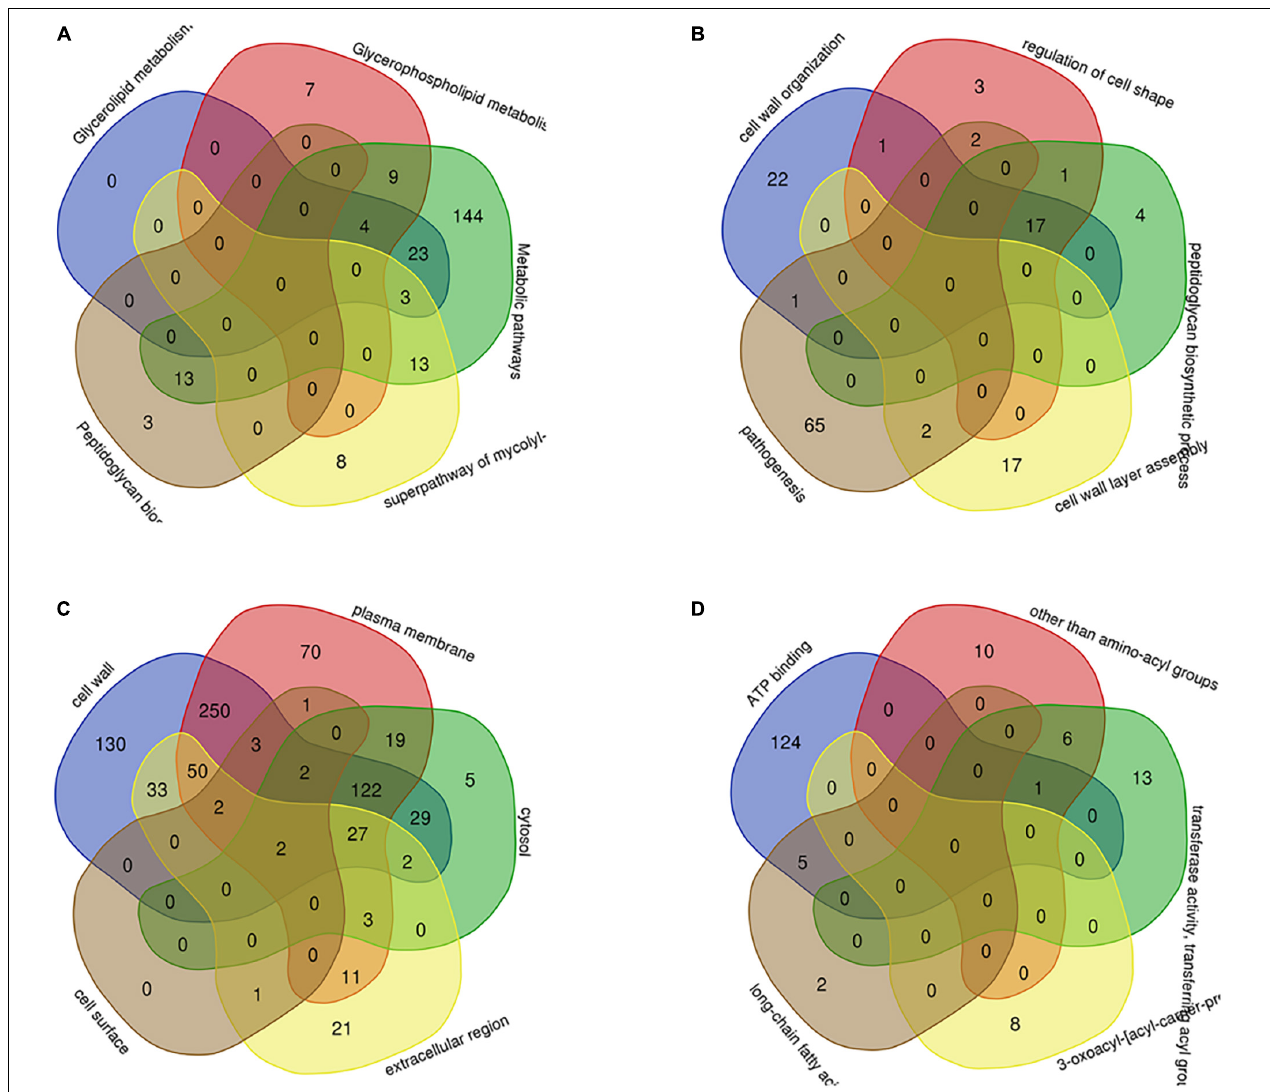
FIGURE 7 | The key genes with multifunctional correlation intermingle through multiple pathways screened for the cell wall-related genes of M. tuberculosis . Intersecting genes in the five pathways with the most significant differences in KEGG (A) , BP (B) , CC (C) , and MF (D) are displayed in a petal